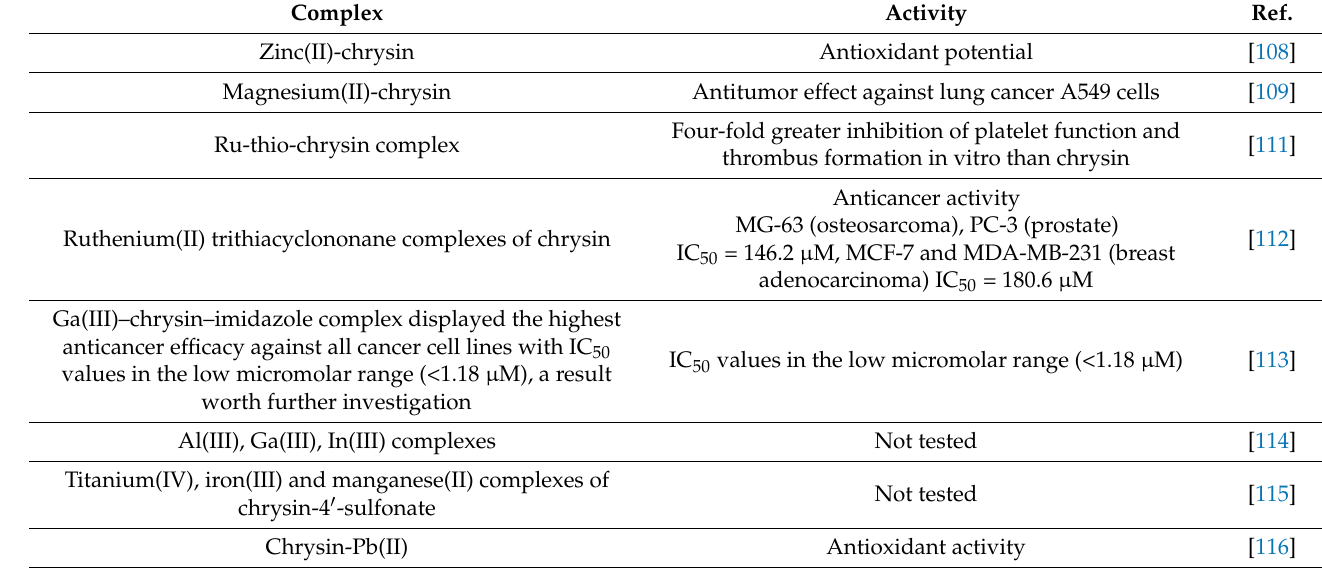
Table 2. Novel chrysin complexes and their biological